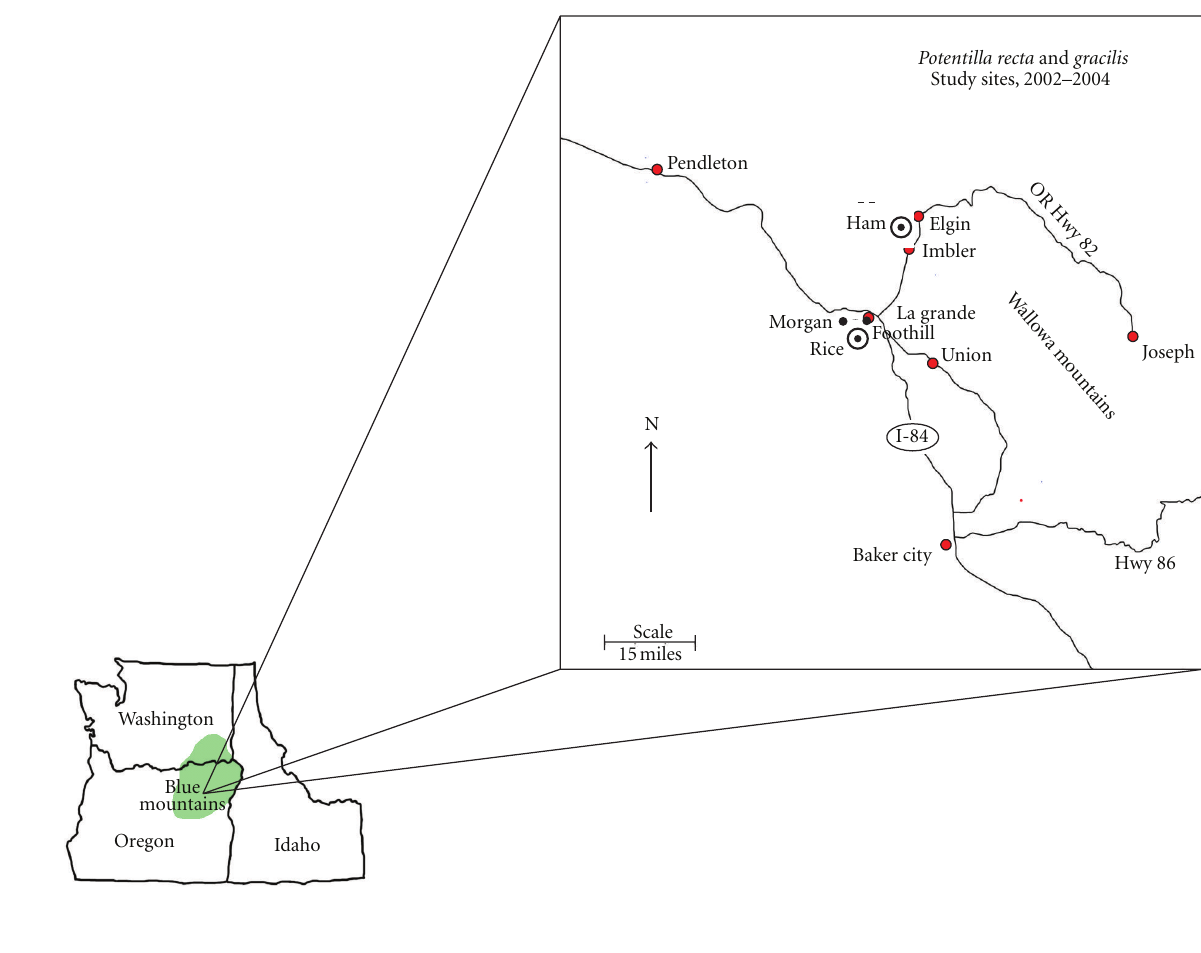
Figure 1: Map of Potentilla study sites, northeastern Oregon,